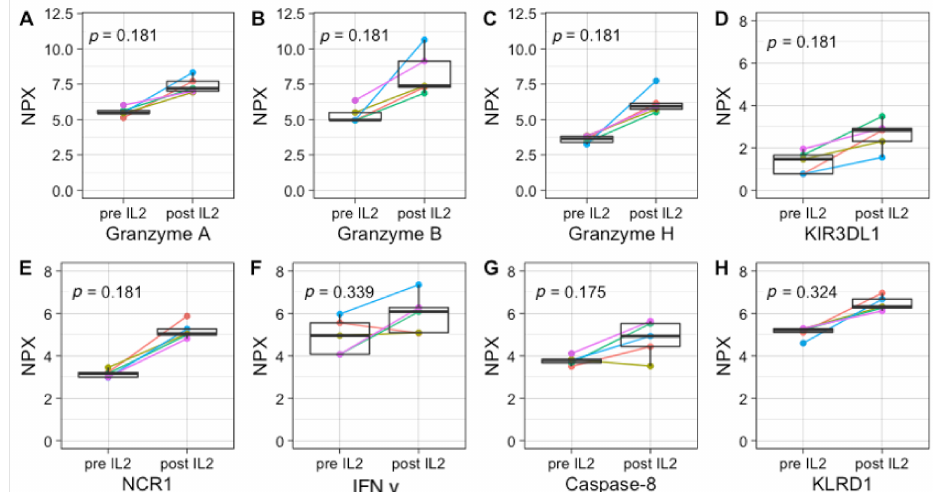
Figure 4. Upregulation of NK-cell activation-associated protein markers upon IL-2-containing immunotherapy cycles. Plasma protein concentration of GZMA/B/H ( p = 0.181) ( A – C ), and KLRD1 ( p = 0.324) ( D ), NCR1 ( p = 0.181) ( E ), IFN-y ( p = 0.339) ( F ), CASP-8 ( p = 0.175) ( G ), and KLRD1 ( p = 0.324) ( H ) pre- and post-IL-2-containing IT cycles. Protein expression is shown as normalized protein expression (NPX). In total, 5 paired samples are shown, as two patients were monitored during both IT cycles.